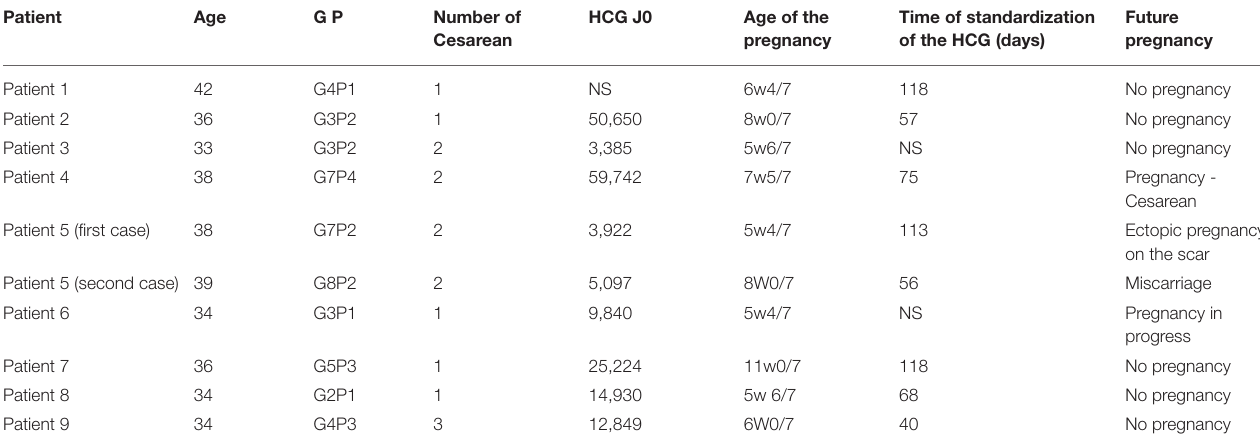
TABLE 1 | Summary table of patients. Patient Age G P Number of